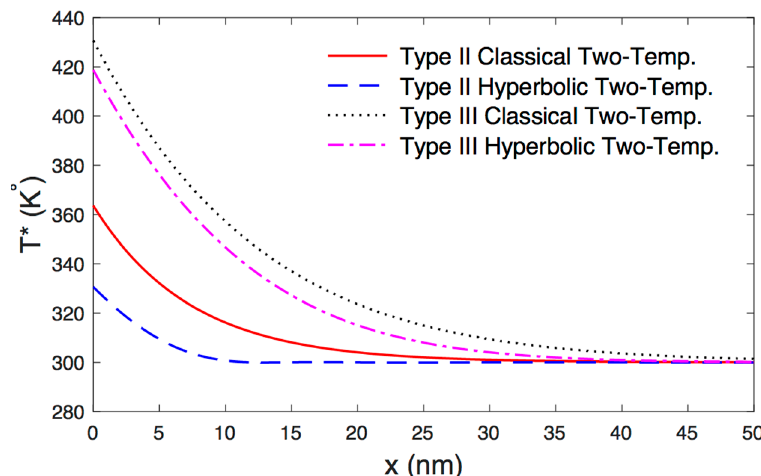
Figure 2. The variation of displacement versus the distance.